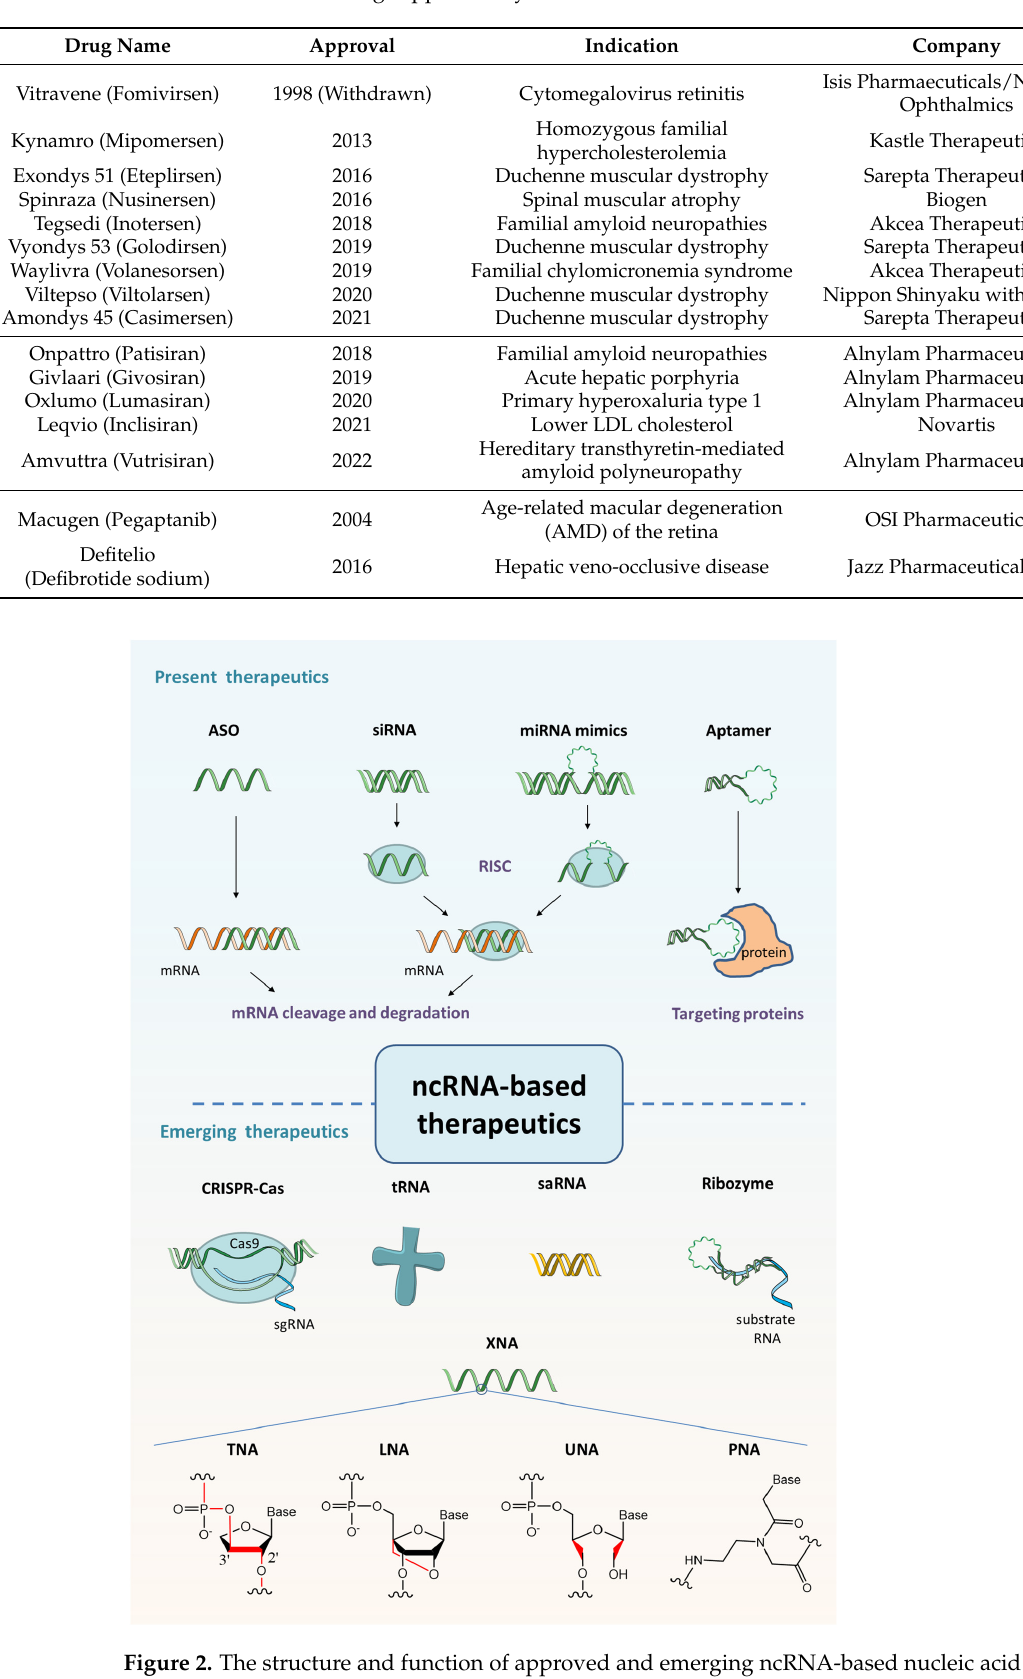
Table 1. Nucleic acid drugs approved by FDA and EMA.